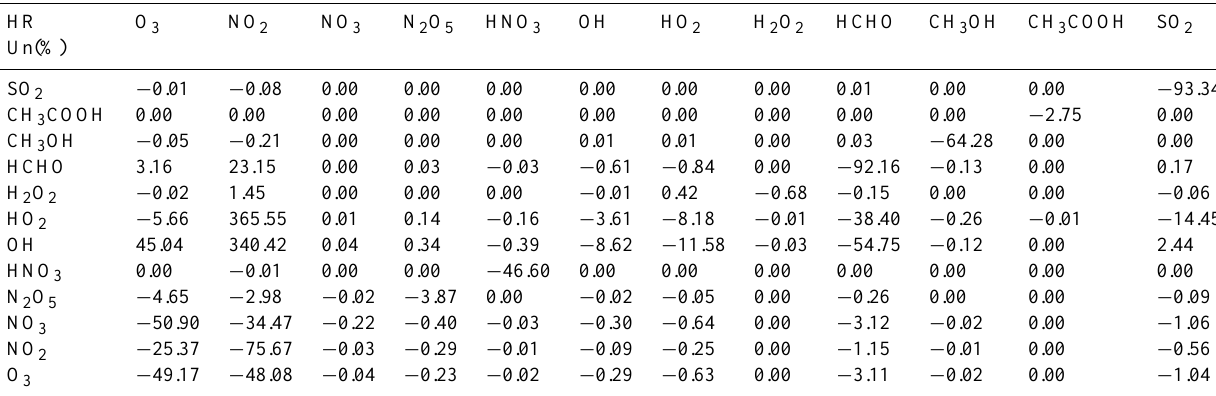
Table 8. Values of the uncertainties corresponding to Fig. 10. Columns are different heterogeneous removal reactions (HR) and rows are uncertainties in the tracer mixing ratios in percent (Un(%)).